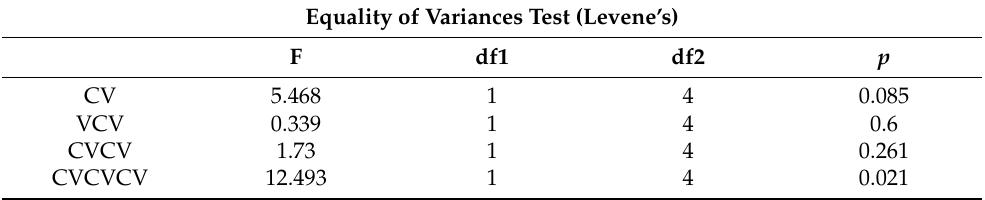
Table 3. Levene’s (homogeneity of variances) of the “type” of vocalization